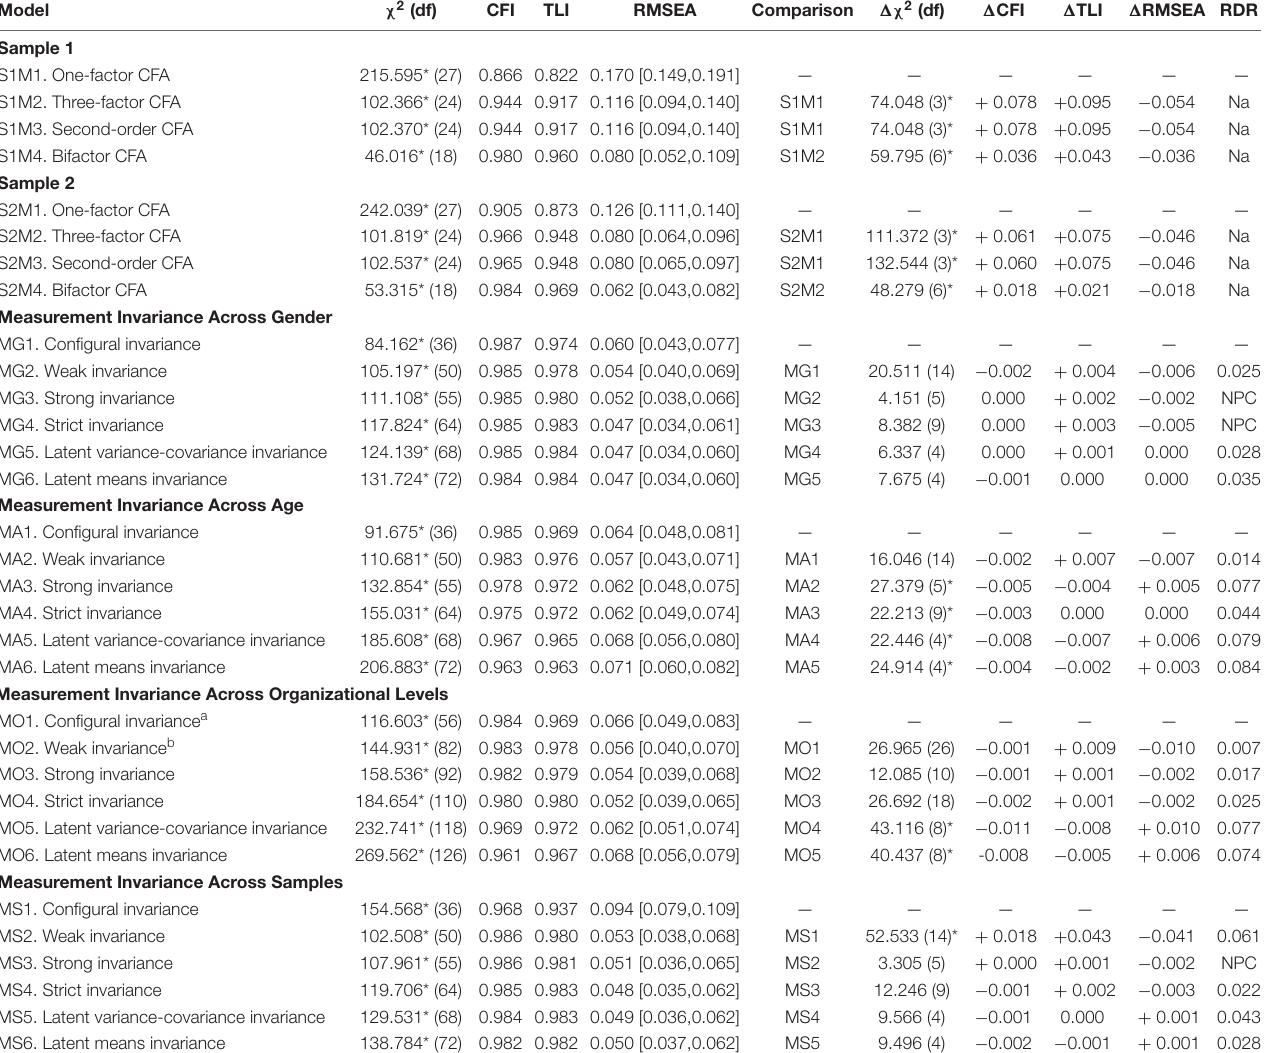
TABLE 1 | Goodness-of-fit statistics of the alternative measurement models on the Hungarian version of Utrecht work engagement scale. Model χ 2